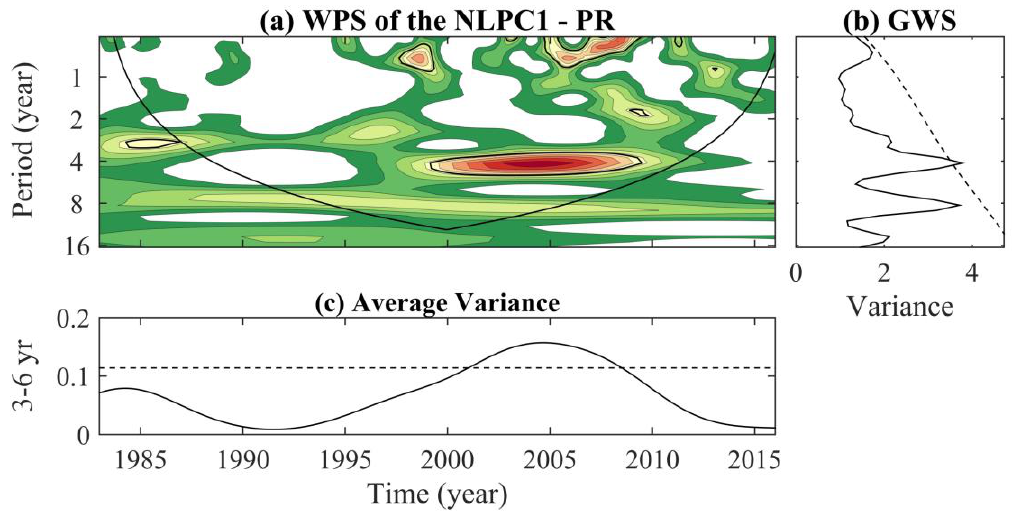
Figure 9. ( a ) Wavelet Power Spectrum (WPS) of NLPC1-PR. The closed contours encompass significant variations with a confidence level of 95%; Under the U-shaped curve, the region where the edge effects are important can be noted; ( b ) global wavelet spectrum (GWS); and, ( c ) 3–6-year Scales-Averaged Power (SAP) of the time series.